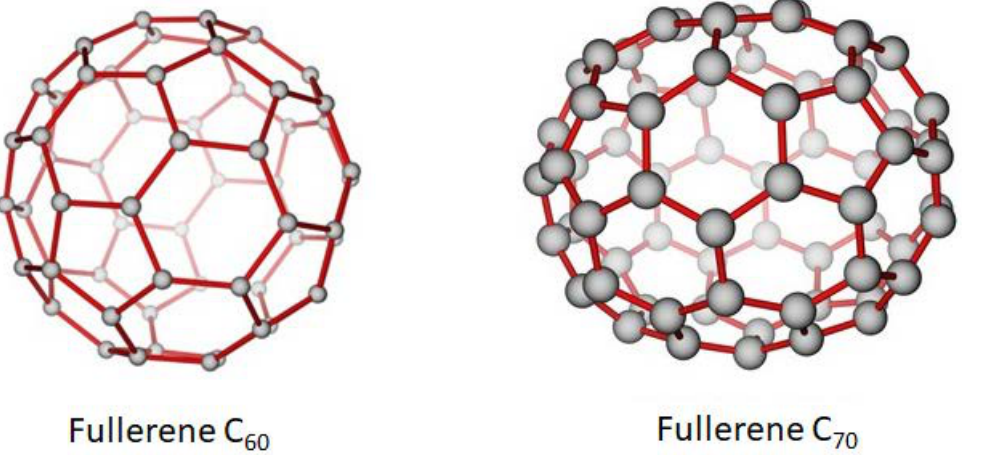
Figure 2. Structure of fullerene C 60 and C 70 .